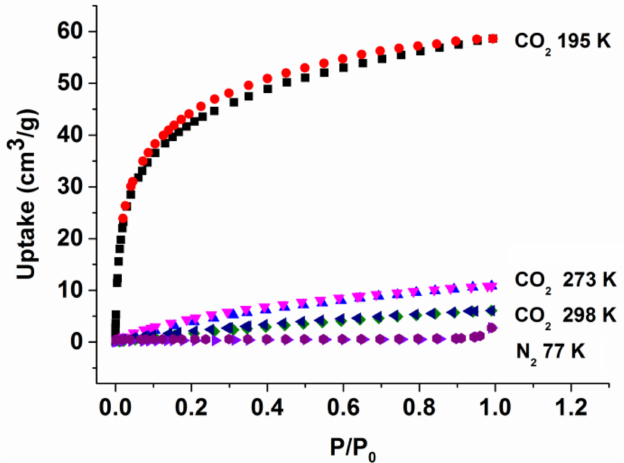
Figure 4. N 2 (77 K) and CO 2 (195 K, 273 K, and 298 K) sorption isotherms for MOF 1 with pressures of up to 1 bar. The black square and red circle represent CO 2 absorption and desorption at 195 K, the blue and pink triangles represent CO 2 absorption and desorption at 273 K, the green square and the dark blue triangle represent CO 2 absorption and desorption at 298 K, while the purple triangle and dark purple hexagon represent N 2 absorption and desorption. P 0 is the saturated vapor pressure of the adsorbates at the measurement